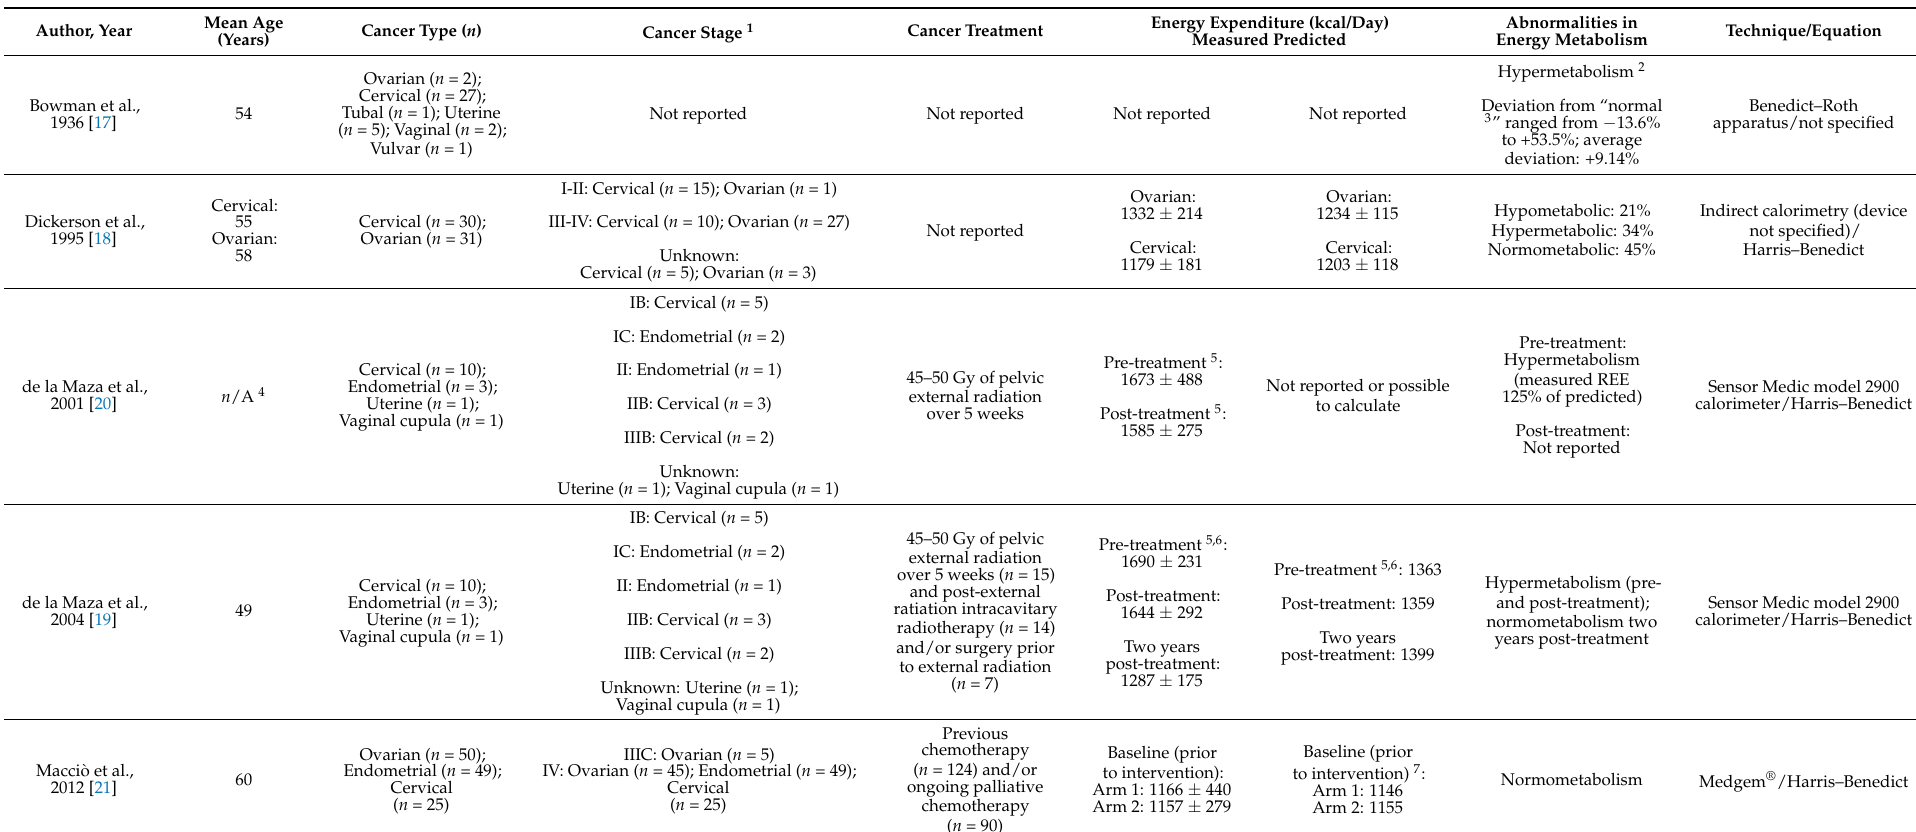
Table 1. Summary of five studies investigating energy metabolism in gynecological